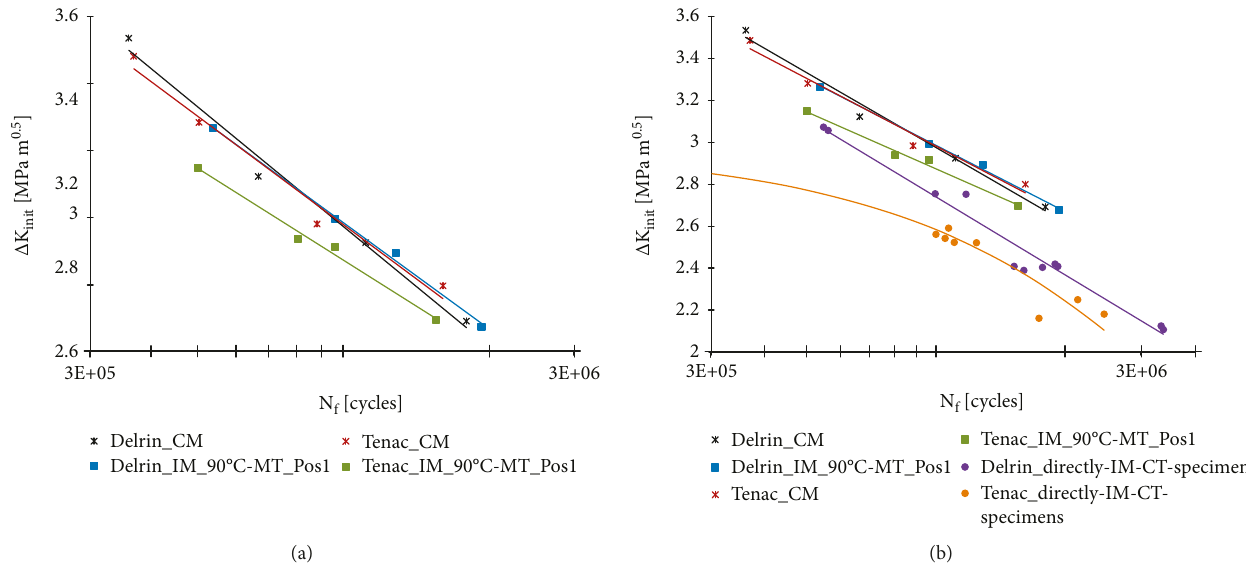
Figure 14: Comparison of fatigue fracture test results of Delrin and Tenac CT specimens. (a) Selected processing conditions used in this study. (b) Additional results obtained for directly injection-molded CT specimens produced under industrial